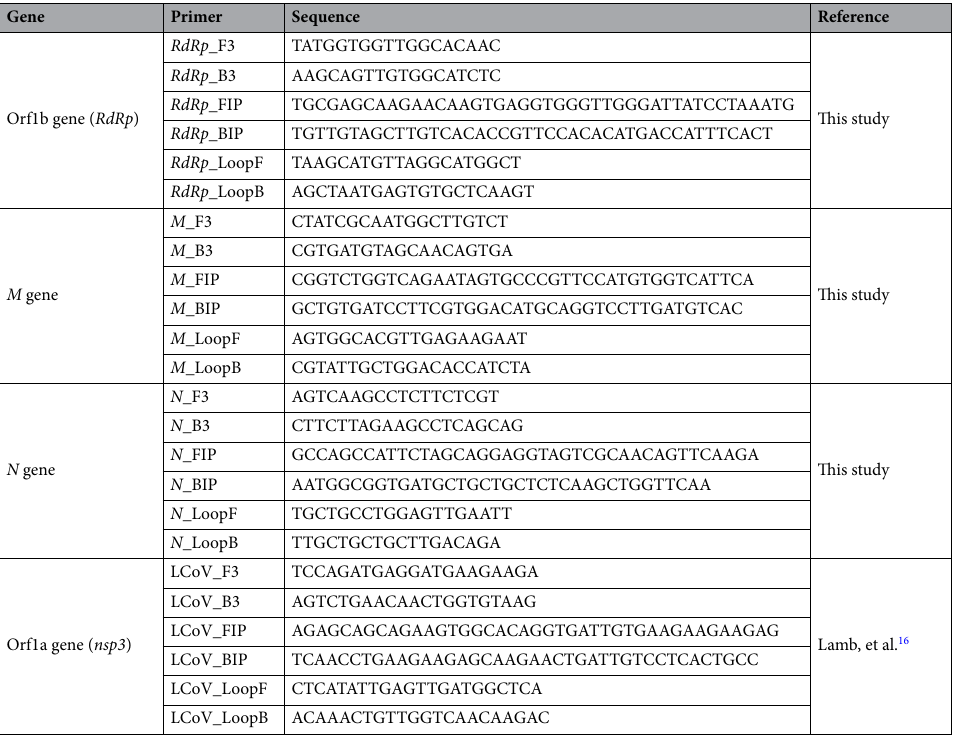
Table 1. RT-LAMP primers for the detection of